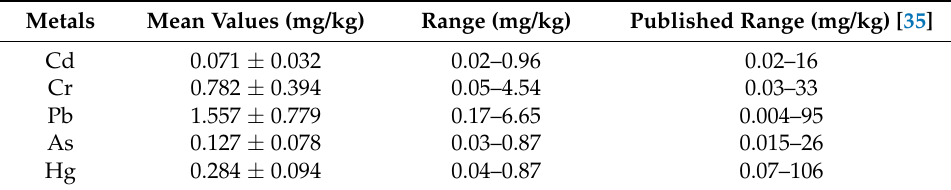
Table 1. Heavy metal concentrations in human hair of Beijing inhabitants.